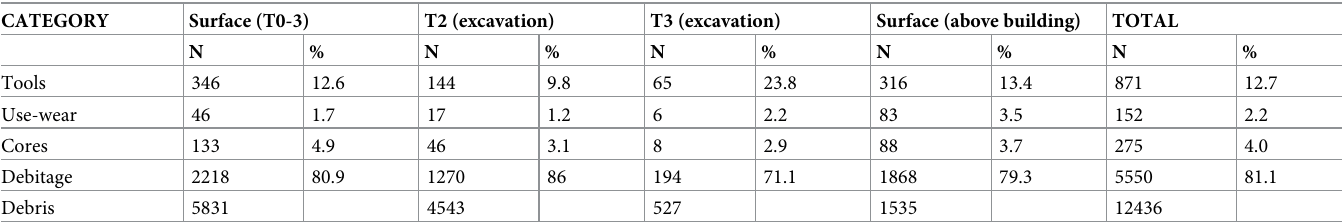
Table 15. The entire lithic assemblage—Kaizer Hill